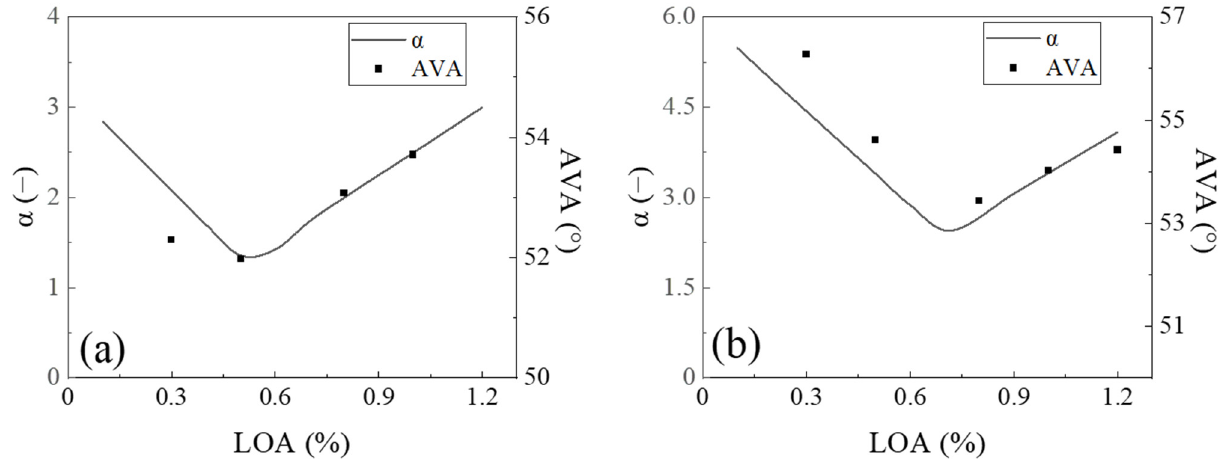
Figure 14. Effects of LOA on flowability of fine particles under different host particle size ( η = 0.1). ( a ) 22 µ m; ( b ) 30 µ m.